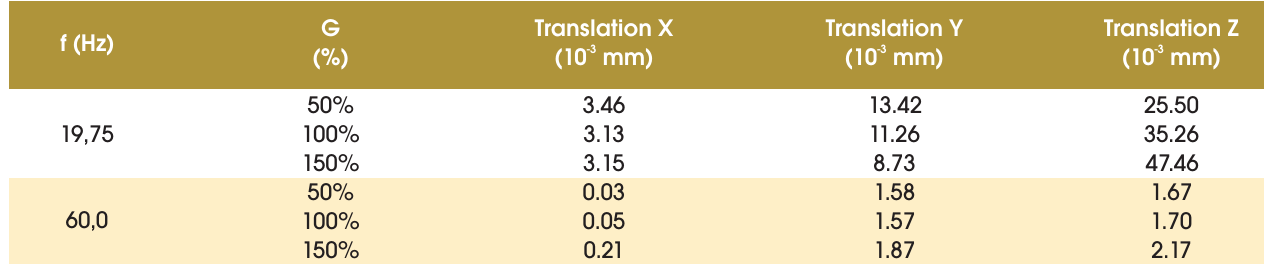
Table 11 – Displacements in directions X, Y and Z for each G value